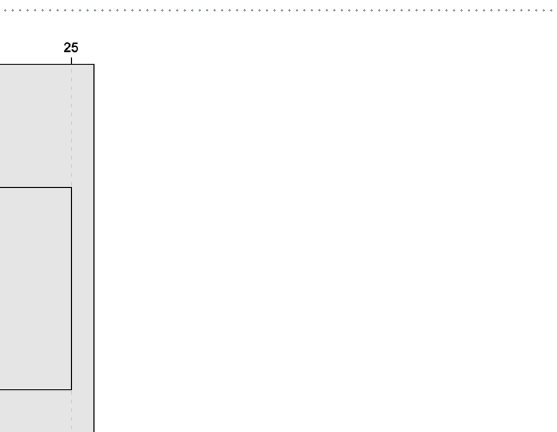
Figure 7. The rescaled range analysis of SPI-12 at different stations.